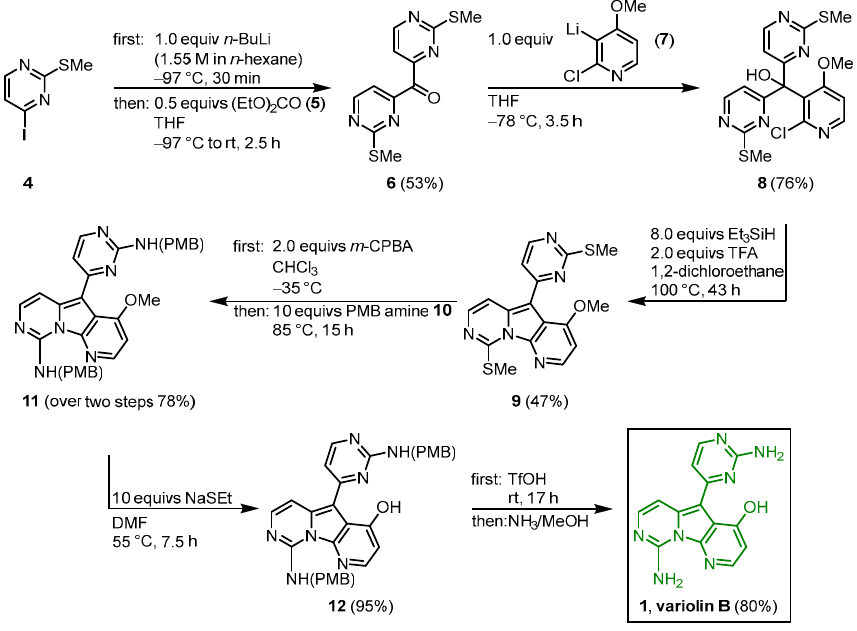
Figure 4. First total synthesis of variolin B ( 1 ) by Morris and Anderson [42].